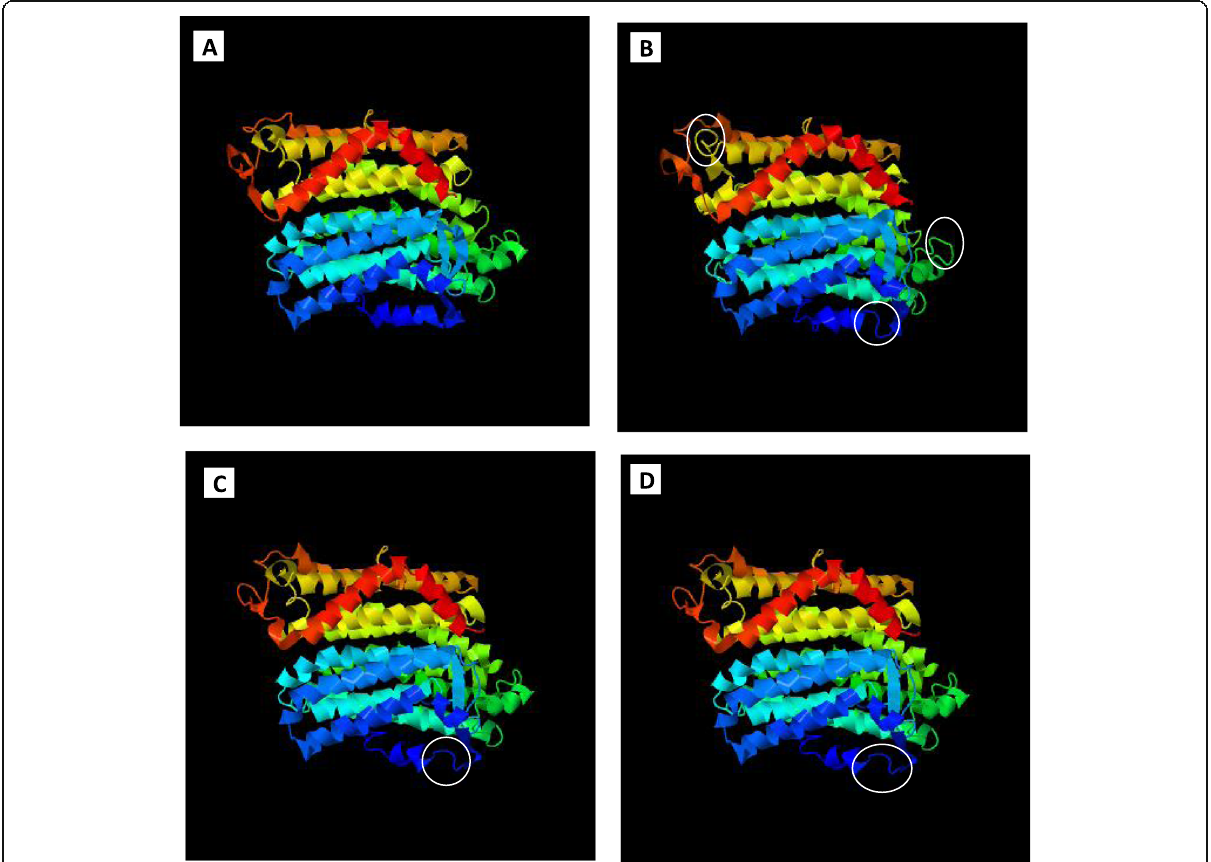
Fig. 5 3D model of C . procera ndhB protein in different three times as well as original protein. a Predicted 3D protein of correspondence DNA coding sequence. b Predicted 3D protein at dawn. c Predicted 3D protein at midday. d Predicted 3D protein at pre-dusk, white circle showed the differences in loop domains occurred from RNA